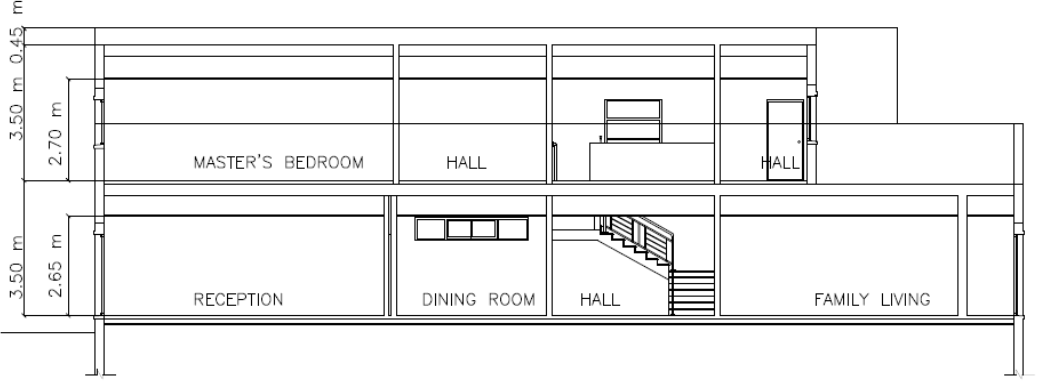
Environments 2017 , 4 , 52 Figure 4. Building elevations. ( a ) Front elevation; ( b ) Side elevation. Figure 4. Building elevations. ( a ) Front elevation; ( b ) Side elevation.